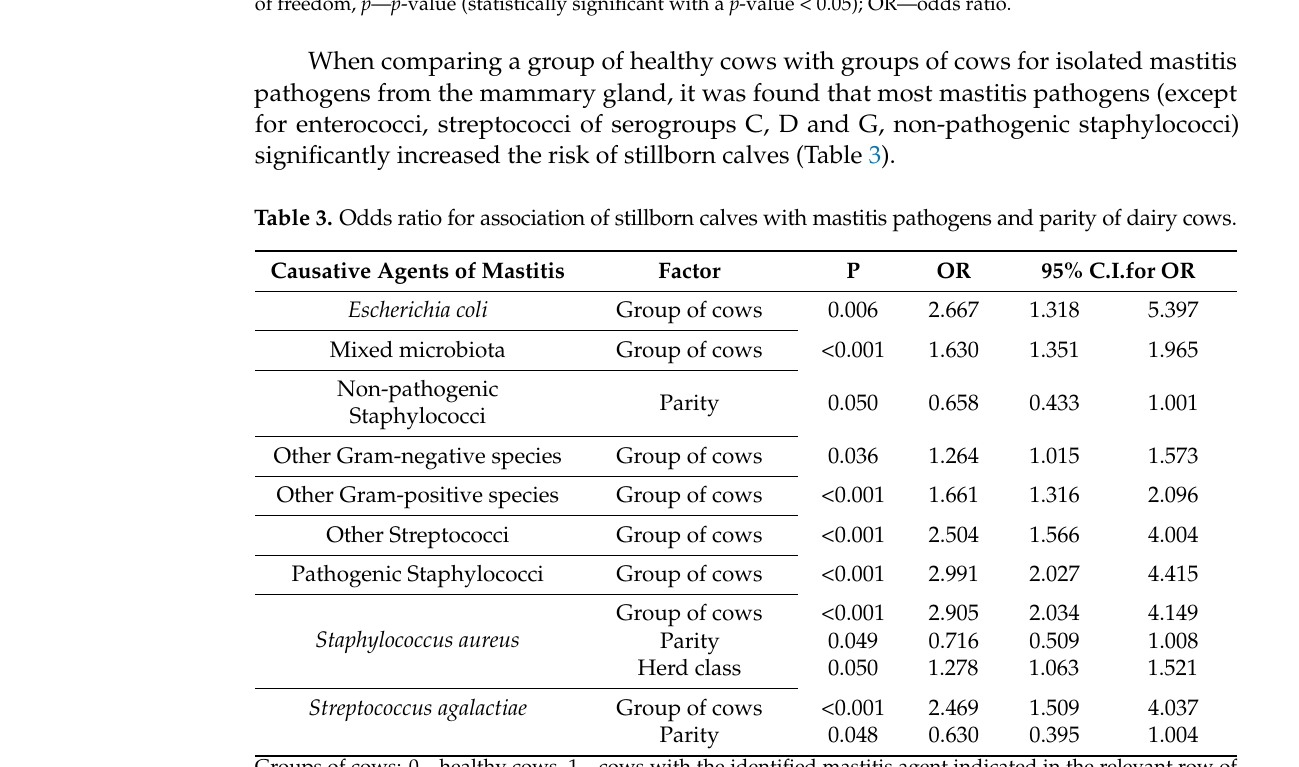
Groups of cows: 0—healthy cows, 1—cows with the identified mastitis agent indicated in the relevant row of the table. Two categories of parities (parity 1 and parity ≥ 2); herd class (100–200 cows and 201–600